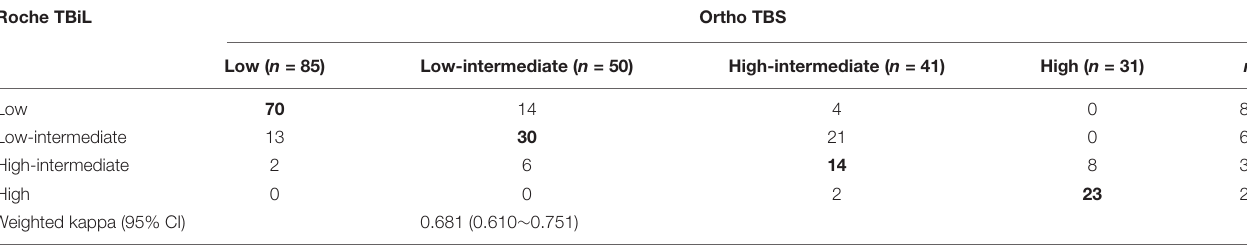
TABLE 2 | Kappa analysis of Roche TBiL and Ortho TSB in neonatal hyperbilirubinemia risk grading. Roche TBiL Ortho TBS Low ( n = 85)